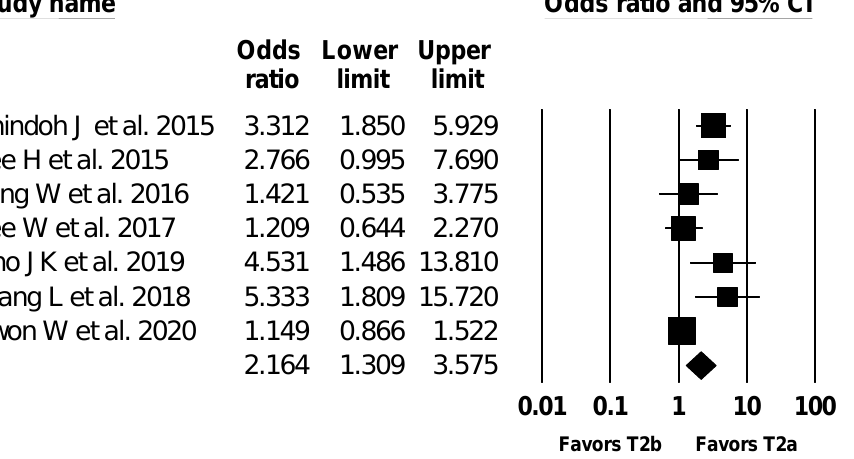
Figure 5. Forest plot of incidence of lymph node metastasis in T2a and T2b GBC patients. The figure depicts individual trials as filled squares with relative sample size and the 95% confidence interval (CI) of the difference as a solid line. The diamond shape indicates the pooled estimate and uncertainty for the combined effect.